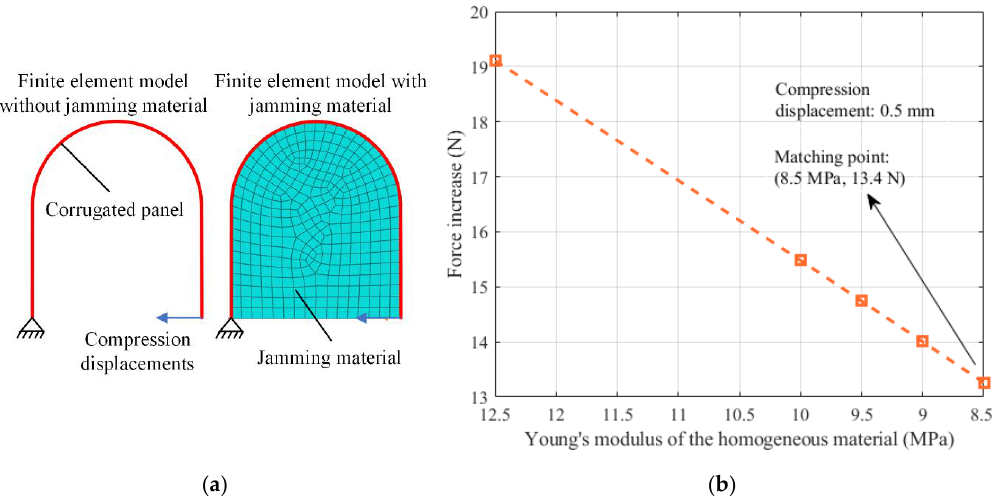
Figure 9. Finite element analysis of the corrugation unit: ( a ) finite element model, ( b ) change in the force increase with the variation in the Young’s modulus of the homogeneous material.